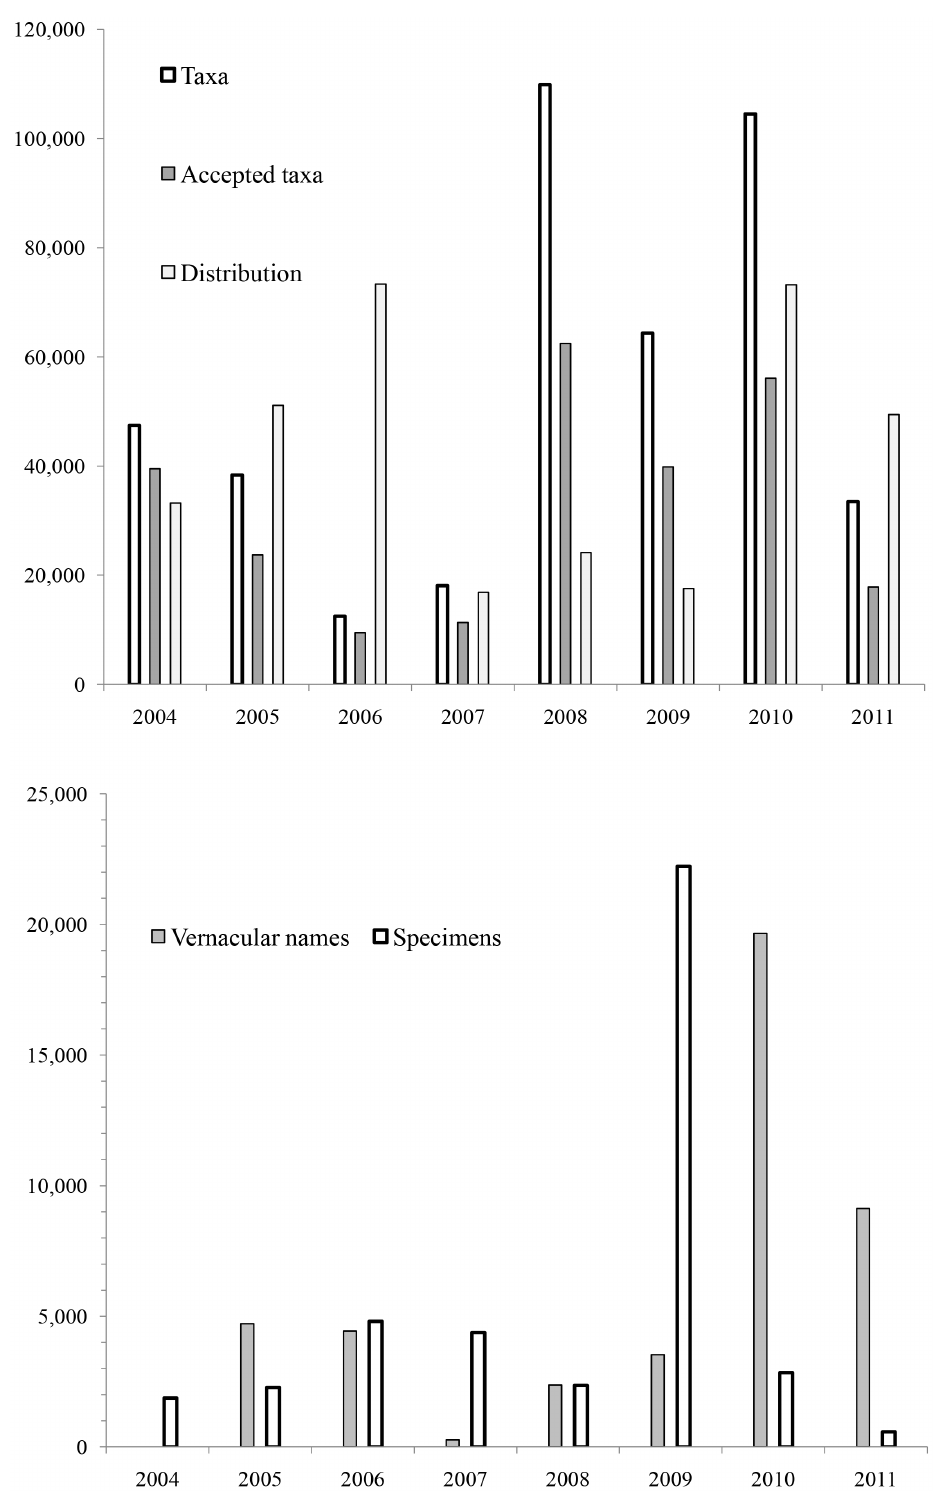
Figure 3. Annual numbers of taxa names (species and above including synonyms), accepted species names, vernacular names, distribution data, and specimens, added to WoRMS and its precursor ERMS.